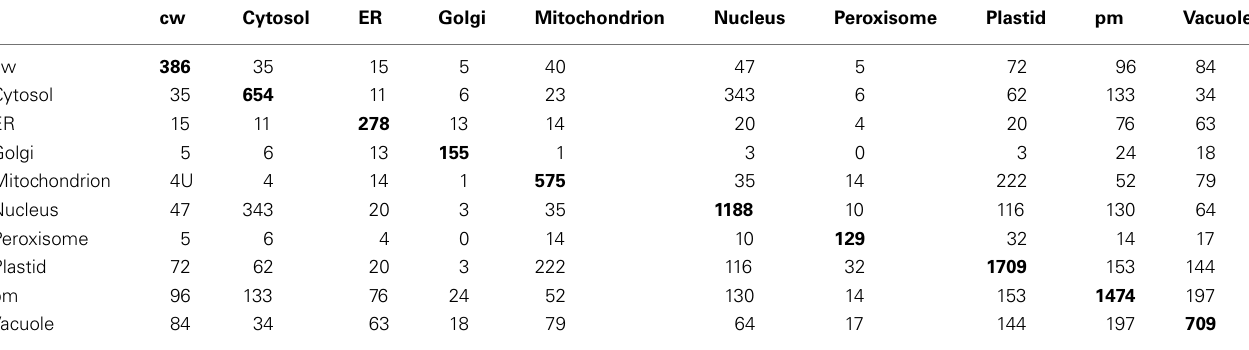
TableA1 | Overlap between localizations for proteins representing 10